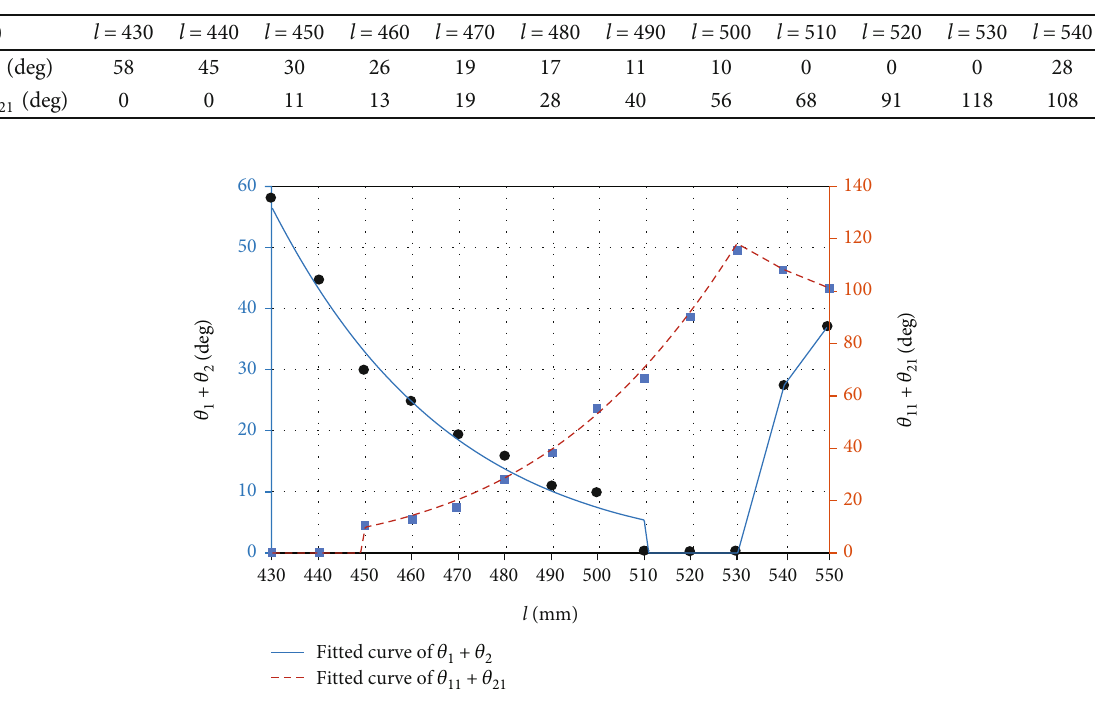
, θ , and θ . (b) The 1 2 3 , θ , and θ . (d) The Bowden 11 21 3